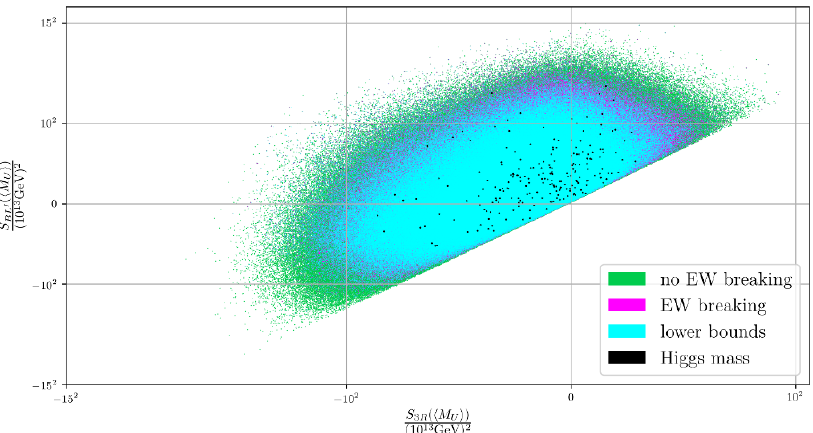
Figure 5. Results from generating 50 million sets of initial data where the B - L scale is chosen from a log-uniform distribution between 10 10 GeV and 10 12 GeV. We (cid:12)nd that 5,949,281 points break B - L but not electroweak symmetry, and 1,937,174 points break B - L and electroweak symmetry. Of the latter 1,283,484 points are consistent with current LHC bounds on sparticle searches. Finally, we have 215 points which satisfy all these conditions and are within the 2 (cid:27) window of the measured Higgs